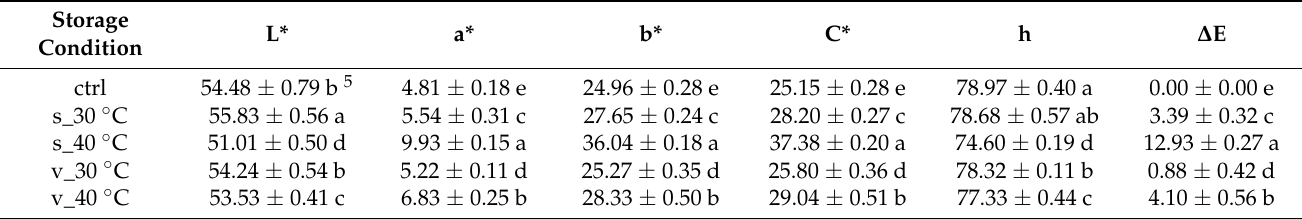
Table 3. Objective colour measurements (L*, a*, b*) and calculated C* 1 , h 2 and ∆ E 3 for M3 4 reconstituted in water (63 g powder/L) before storage (control, ctrl) and after storage at 30 ◦ C/65% RH and 40 ◦ C/65% relative humidity for 1 month in glass sealed vials (v) and semi-permeable sachets (s).